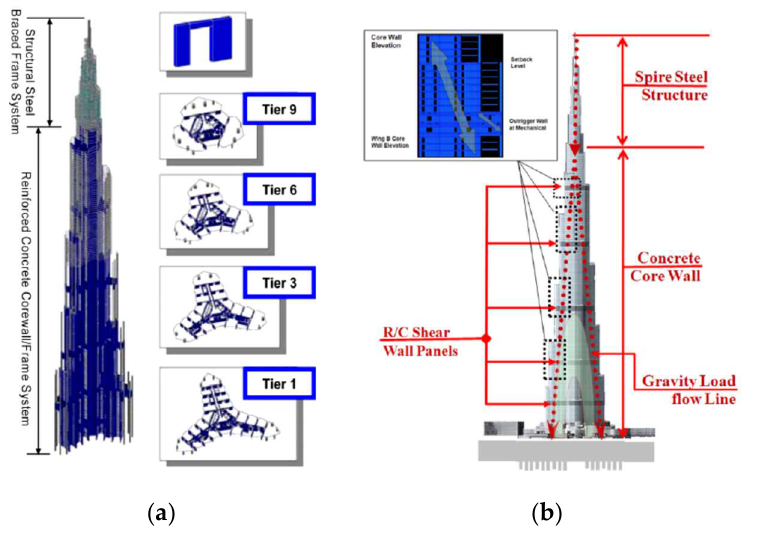
Figure 9. ( a ) Lateral load resisting system at mechanical floors, ( b ) lateral load resisting system and gravity. Source: [6].